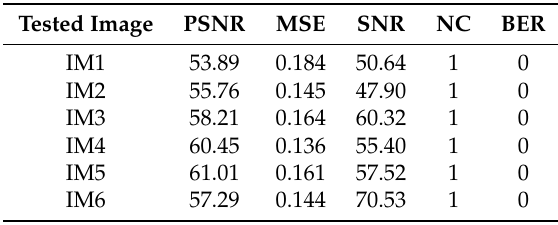
Table 2. Data owner depth circuit execution time